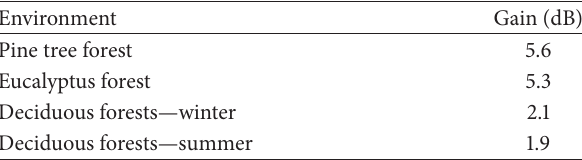
Table 4: Receiver spatial diversity power gain (dB). Table 5: Double-end diversity power gain